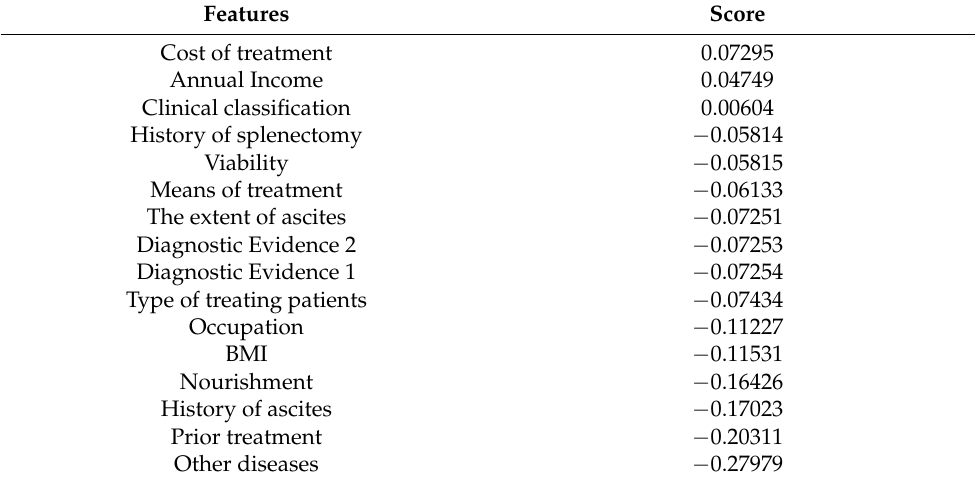
Table 3. Features